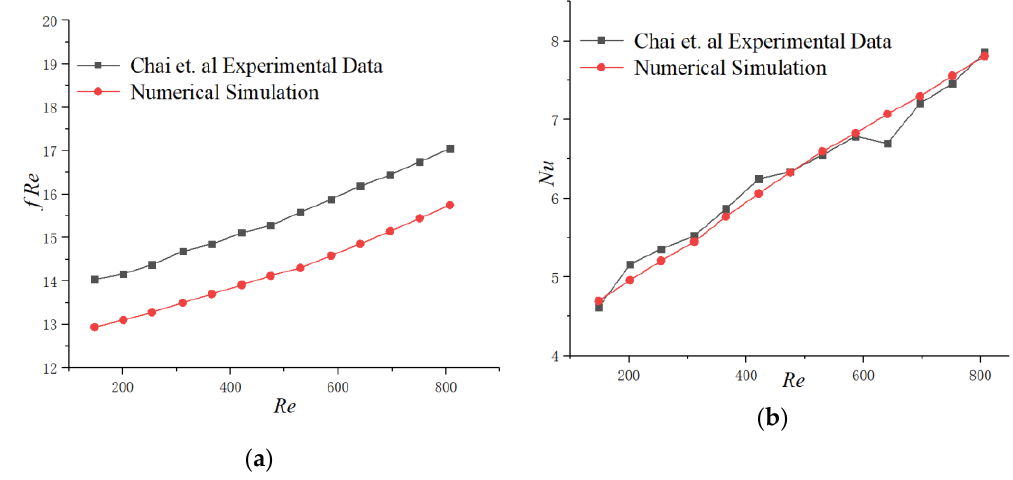
Figure 4. Comparison of numerical results with experimental data [25]. ( a ) fRe ( b ) Nu